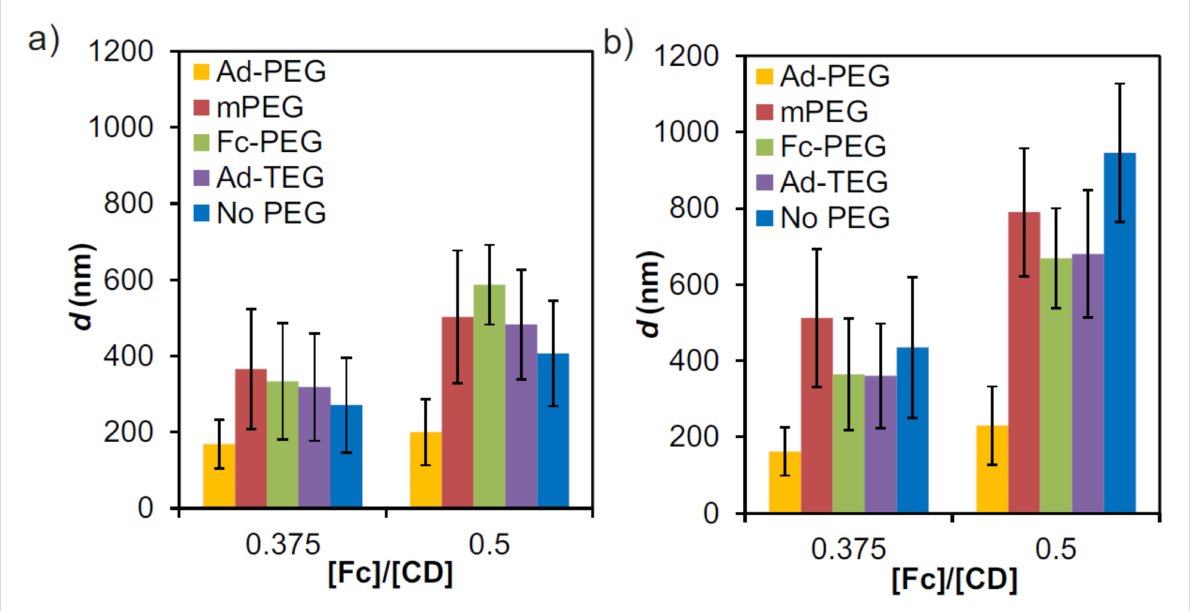
Figure 6: DLS size determinations of SNPs prepared from CD-PEI, Fc 8 -PAMAM, in the absence or presence of a monovalent stopper, for two [Fc]/[CD] ratios (in Fc and CD moieties from Fc 8 -PAMAM and CD-PEI, respectively) keeping constant both [CD] = [Fc] + [stopper] = 100 uM (where [stopper] is the concentration of the monovalent stopper), using 0.2 M NaCl and different stoppers: Ad-PEG, mPEG (no guest moiety), Fc-PEG, Ad-TEG and without stabilizer after: a) 20 min and b) 4 h.